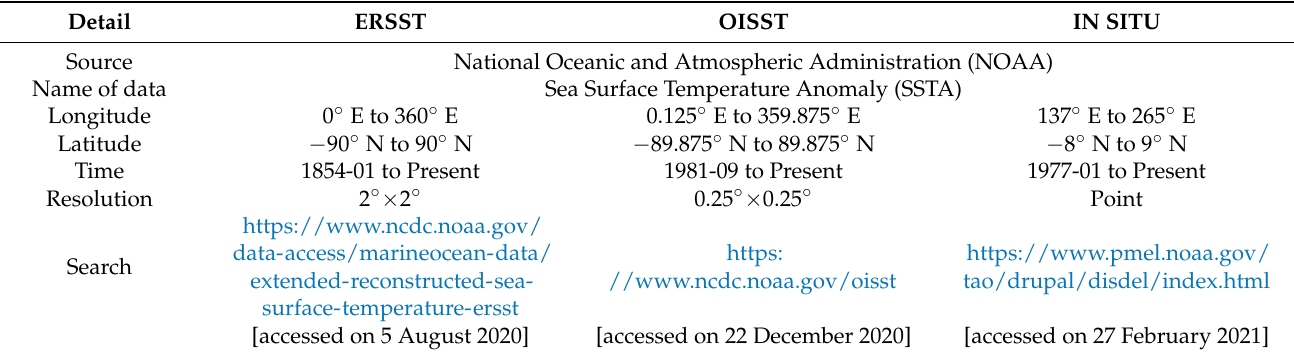
Table 1. Details of the data in this